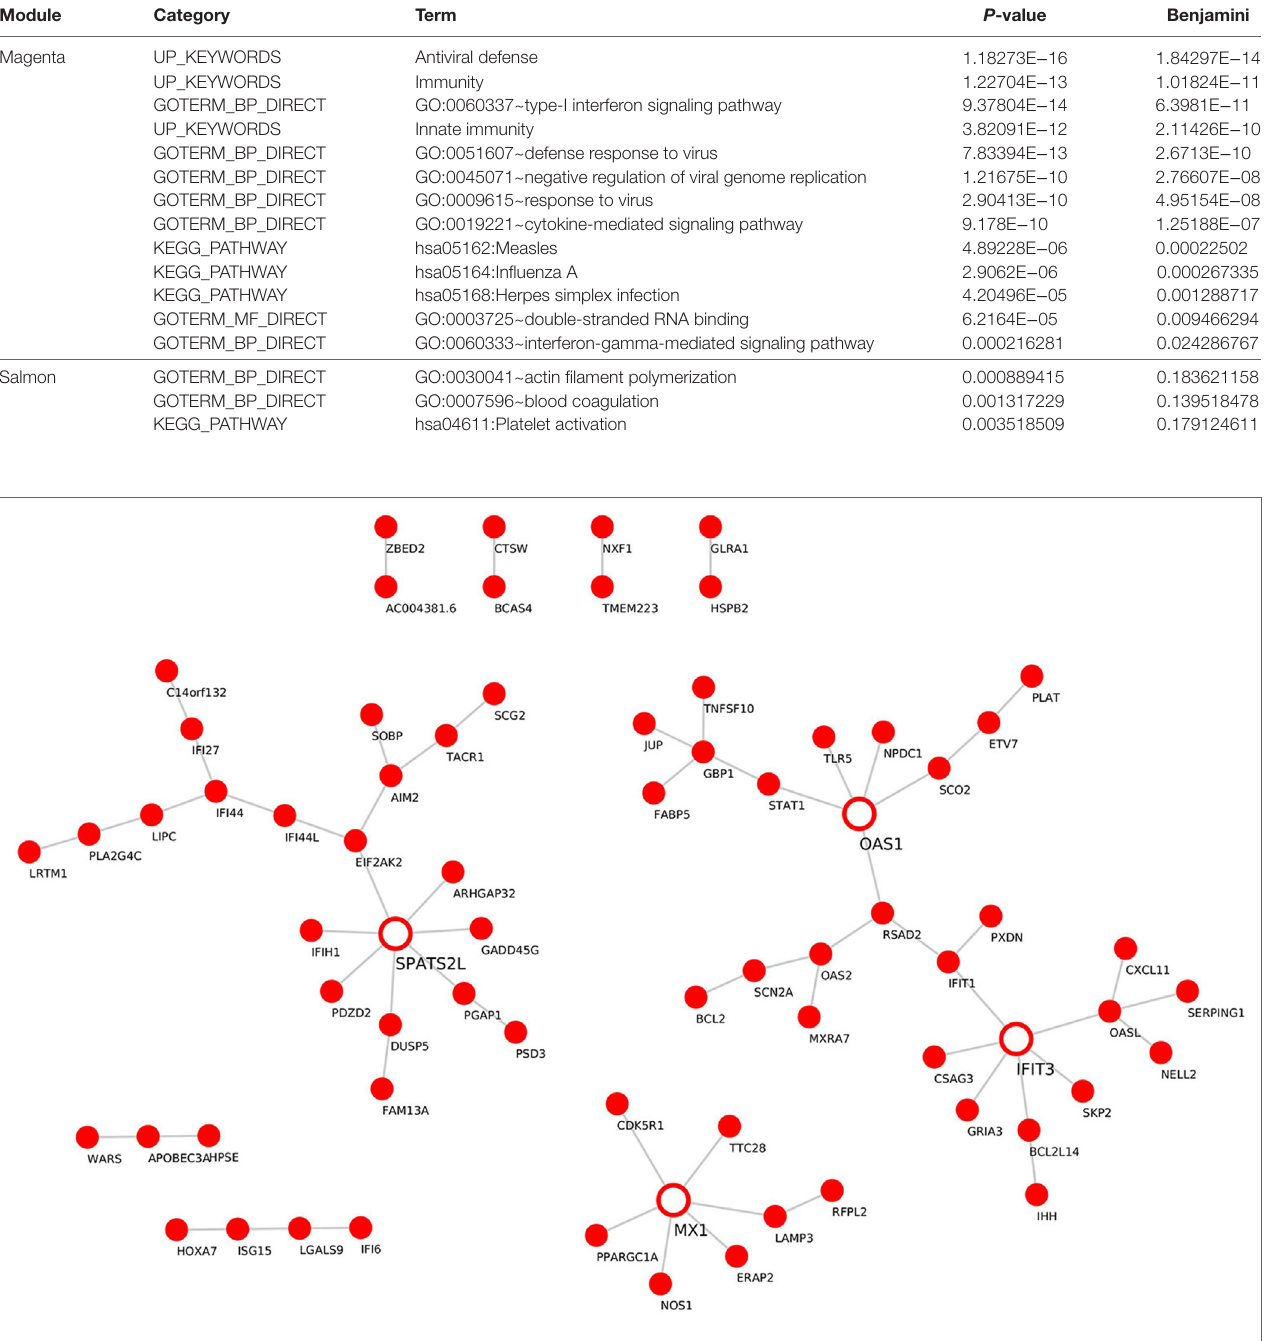
FigUre 3 | Gene–gene interaction network for the “magenta” module. De novo network generated by C3NET algorithm for the “magenta” module. The figure shows statistically significant ( α < 0.05) edges predicted by the algorithm. Fully colored nodes represent the “magenta” module-associated genes. Empty nodes represent the regulatory genes (degree ≥